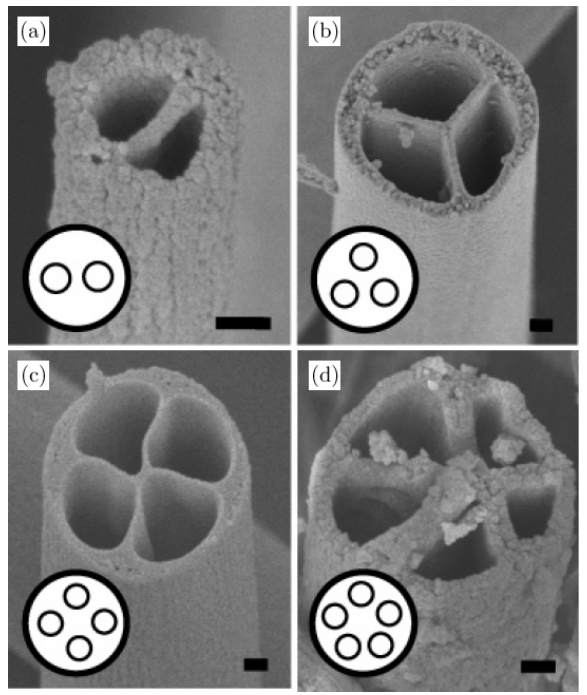
Fig. 2. SEM images of nano¯bers with di®erent spinnerets. Scale bars are 100 nm.